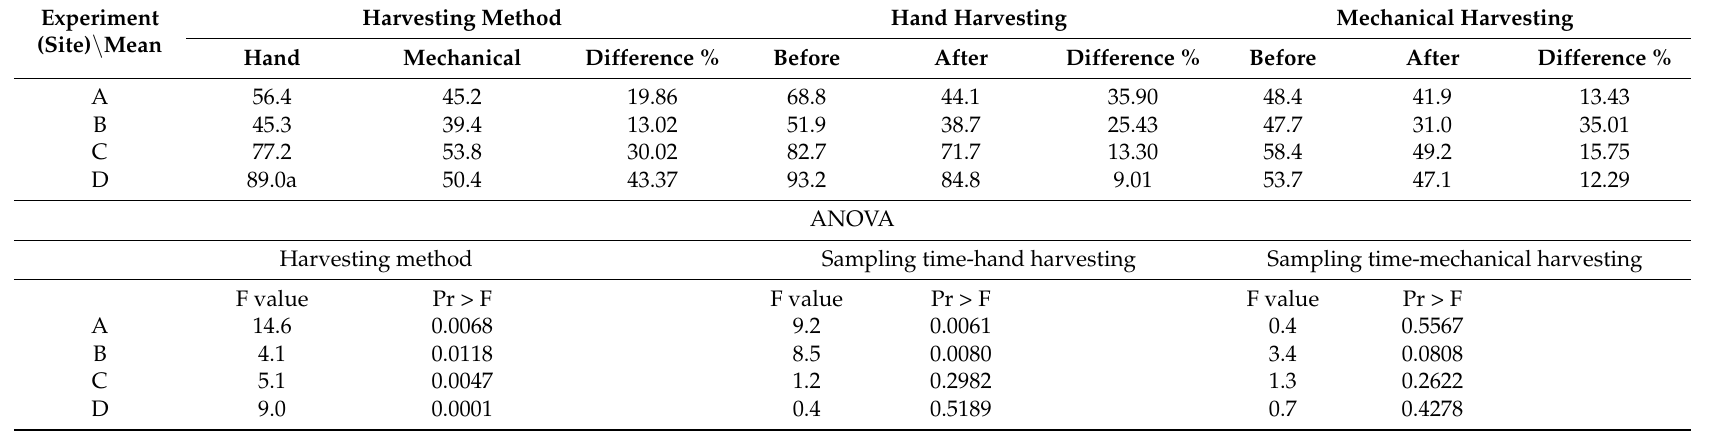
Table 2. Means and analysis of variance for the harvesting methods effect on sap flow (g h − 1 ) at Felda site in the southwest of Florida during 2015 and 2016 seasons.